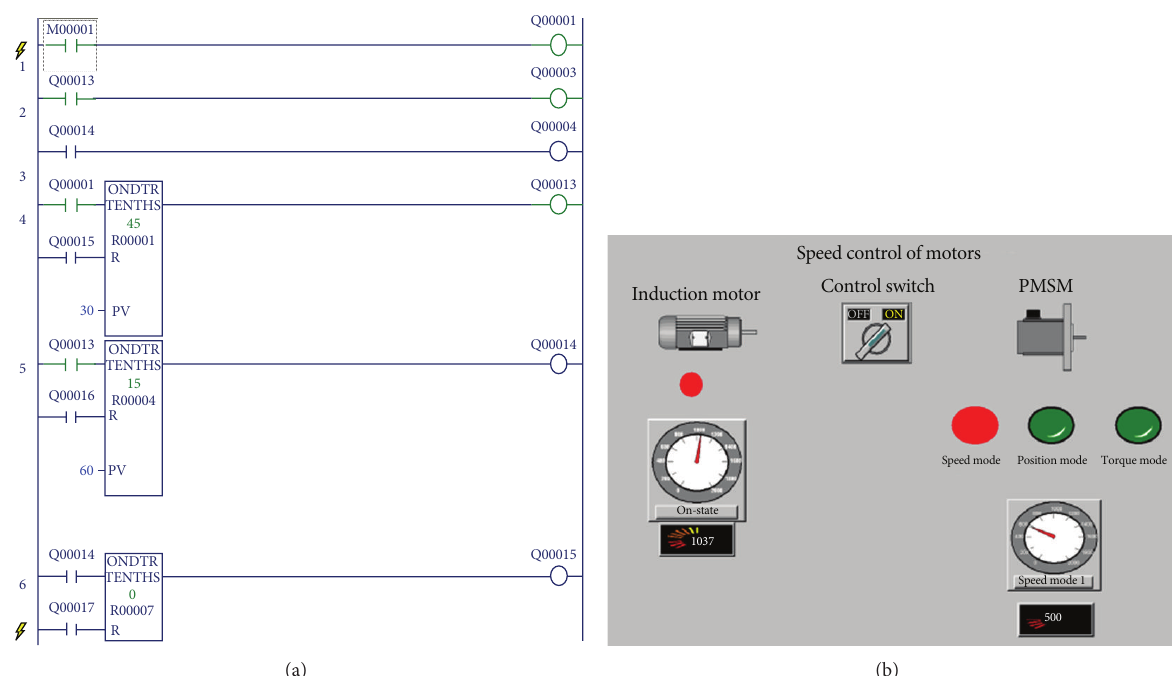
Figure5:(a)LadderlogicforintegratedoperationofIMandPMSMdrives.(b)SCADAGUIdevelopedforthespeedcontrolofthedistributed drives.